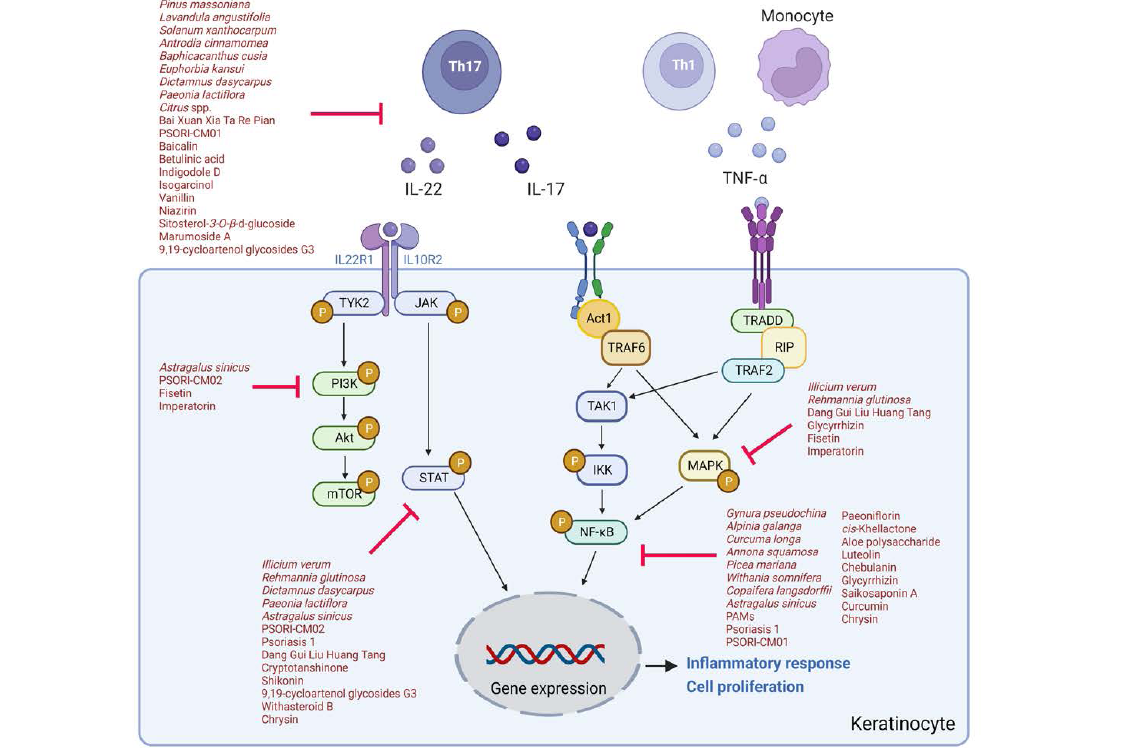
Figure 2. The signaling pathways underlying anti-psoriatic effects of natural products. Act1: NF-κB activator 1; P: phosphorylated; RIP: ribosome inactivating protein: TAK1: transforming growth factor-β-activated kinase 1; TRADD: Tumor necrosis factor receptor type 1-associated death domain; TRAF6: tumor necrosis factor receptor-associated factor